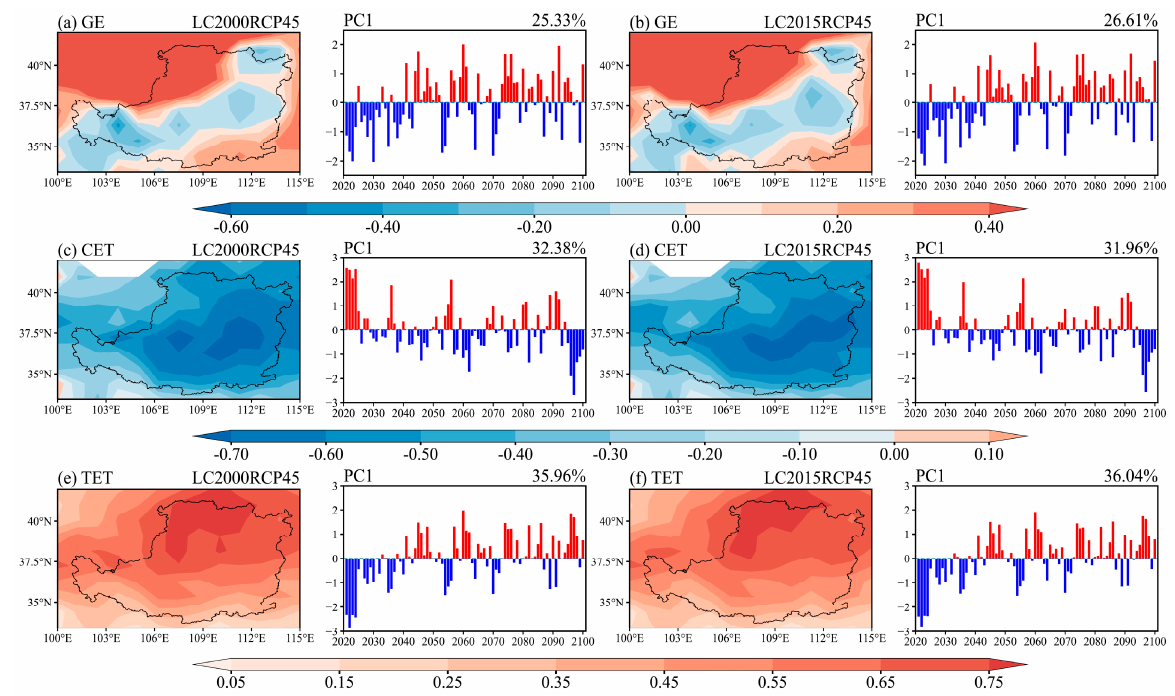
Figure 8. Comparison of spatial patterns and time series of the first EOF modes for responses of ET to different land cover conditions during 2021–2100 in the LP under the RCP4.5 scenario. The left two columns ( a , c , e ) and right two columns ( b , d , f ) show the spatiotemporal patterns of ground evaporation, canopy ET and total ET for the land cover conditions in 2000 and 2015, respectively.